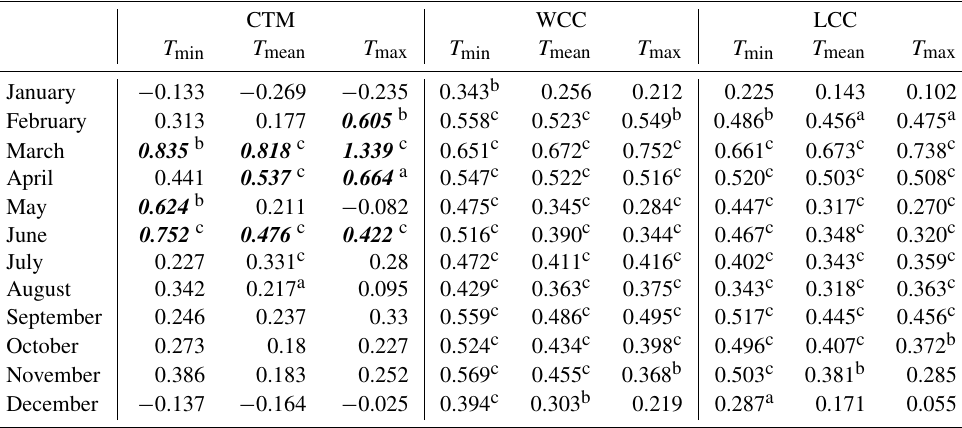
Table 4. Monthly temperature trends ( ◦ C10a − 1 ) in the CTM (based on the CTMD) and all of continental China (WCC) and low-elevation areas (LCC) by excluding the CTM and the QTP from the WCC (both based on the CMA05) from 1979 to 2016.